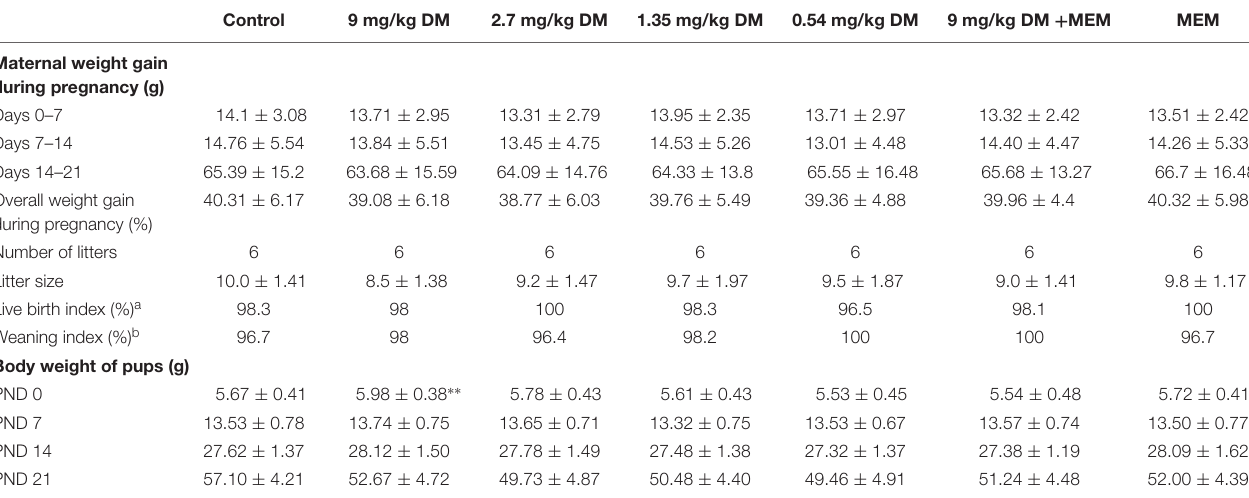
TABLE 1 | Weight gain of dams and parameters of rat pups following prenatal exposure to deltamethrin and/or memantine. Control 9 mg/kg